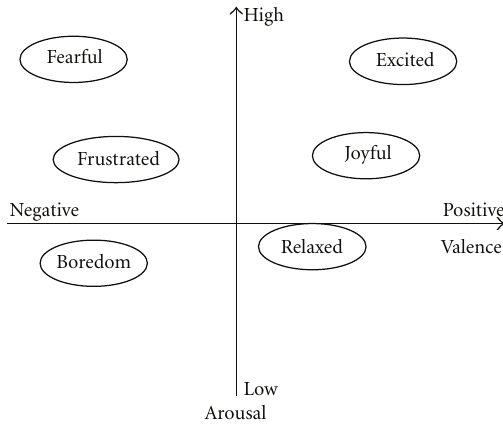
Figure 2: Two-dimensional a ff ective (arousal/valence)